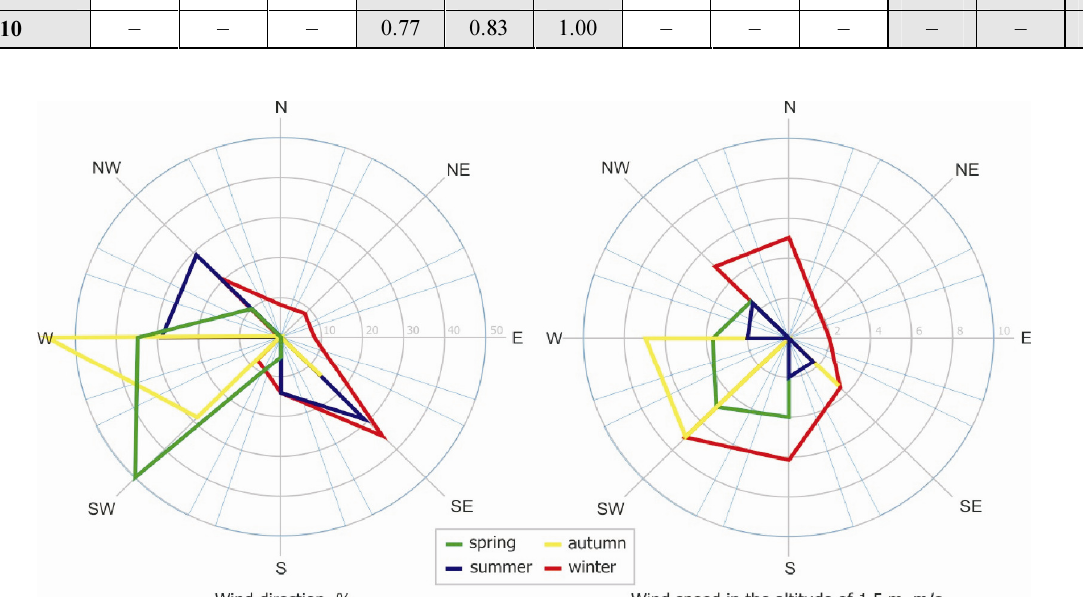
Fig. 2. Dominant wind speed and wind direction during air